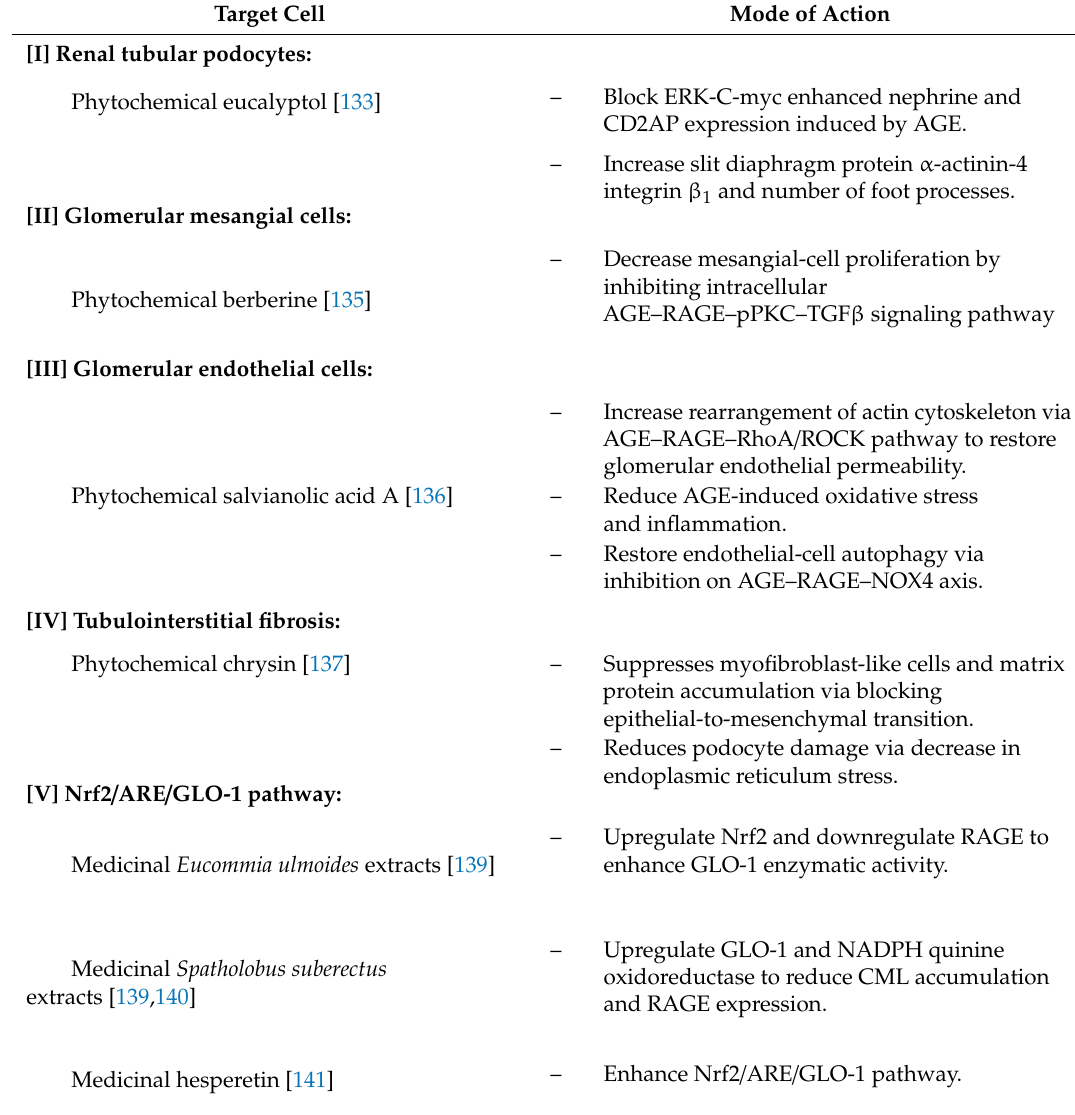
Table 3. Novel phytochemicals and medicinal extracts with di ff erent anti-AGE activity in protecting from diabetic